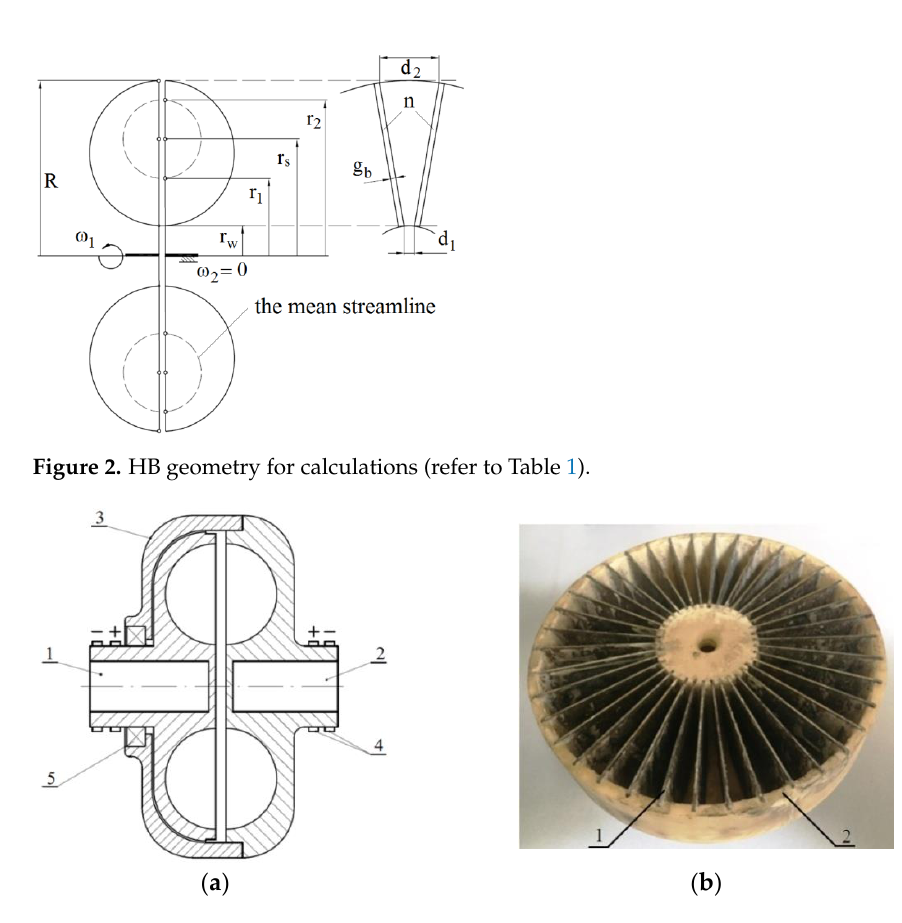
Figure 3. PHB with the ER fluid: ( a ) — design solution: 1 — pump, 2 — turbine, 3 — casing, 4 — slip